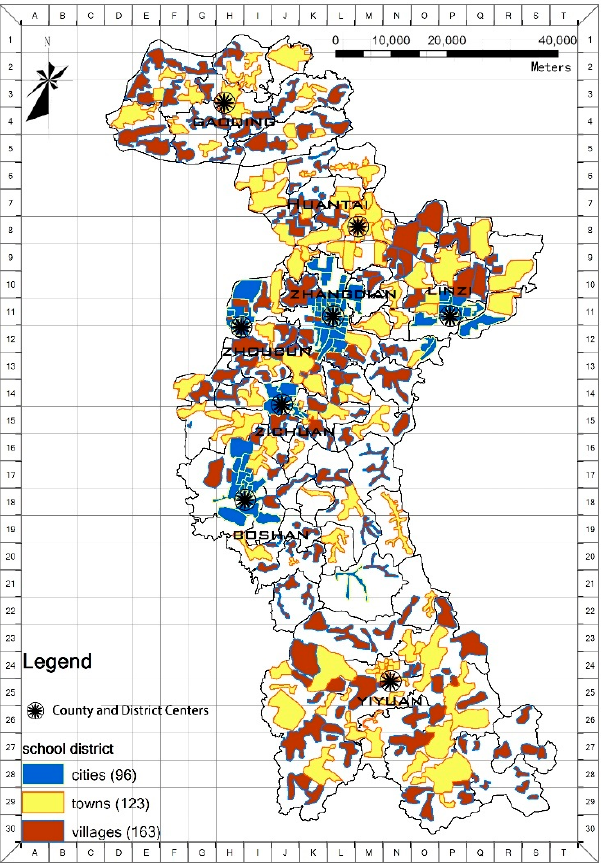
ffi liation classification of primary schools’ distribution in Zibo Figure 1. The administrative affiliation classification of primary schools’ distribution in Zibo City. Figure 1. The administrative a